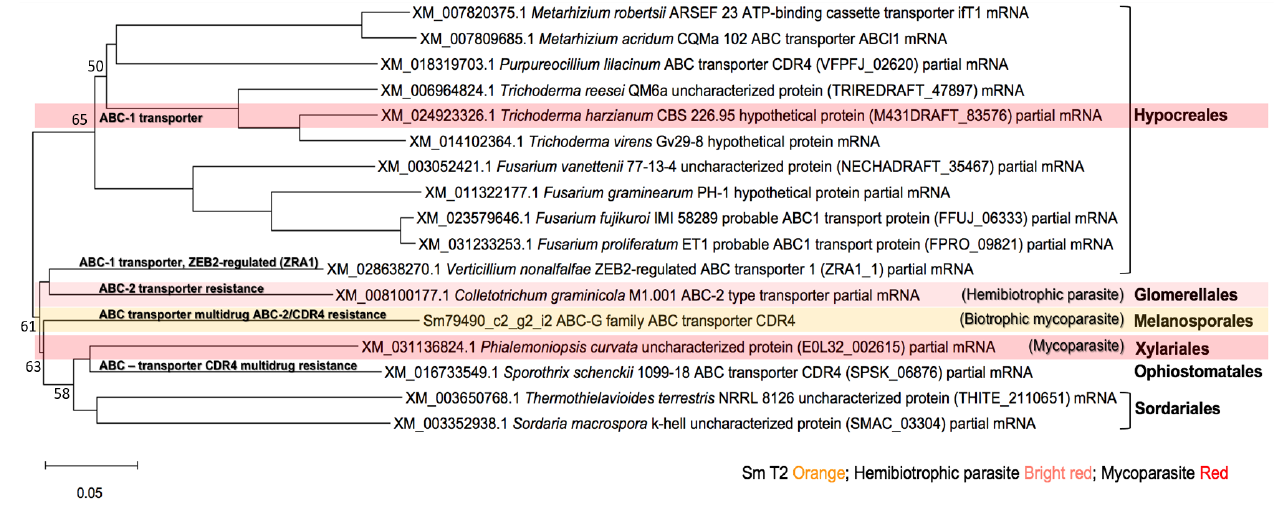
lilacinum (GenBank acc. no. XM_018320663) (Figure